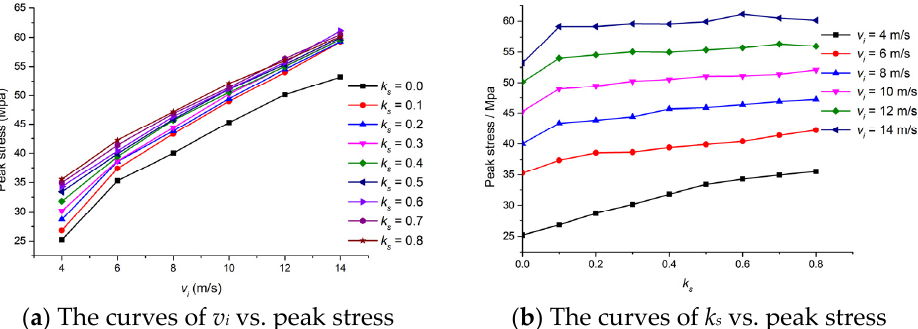
Figure 4. Peak stress of coal specimens subjected to different pre-stress levels and impact speeds.